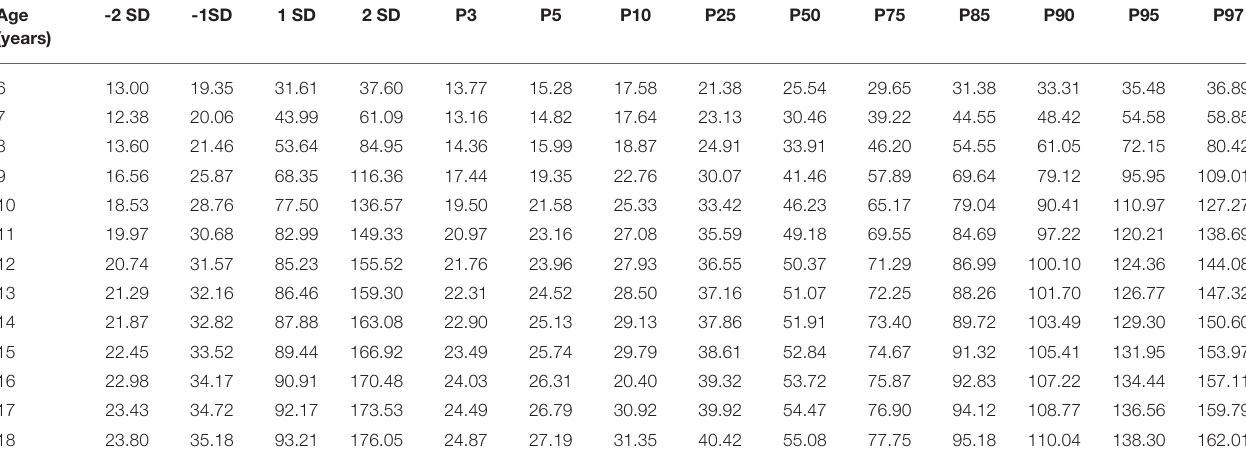
TABLE 3 | VAT-for-age (cm 2 ) references for boys.